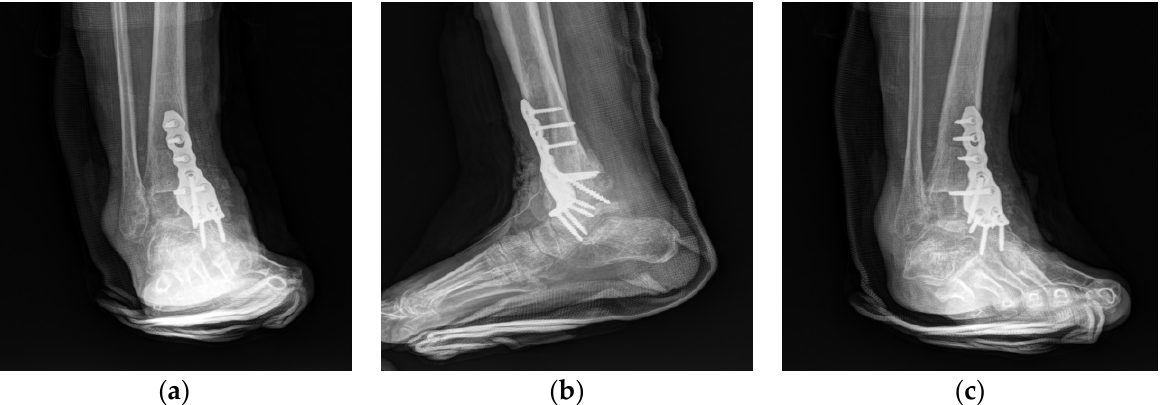
Figure 7. Postoperative plain anteroposterior ( a ) , lateral ( b ), and oblique ( c ) radiographs showing deformity correction and anterior plating with a bone graft.